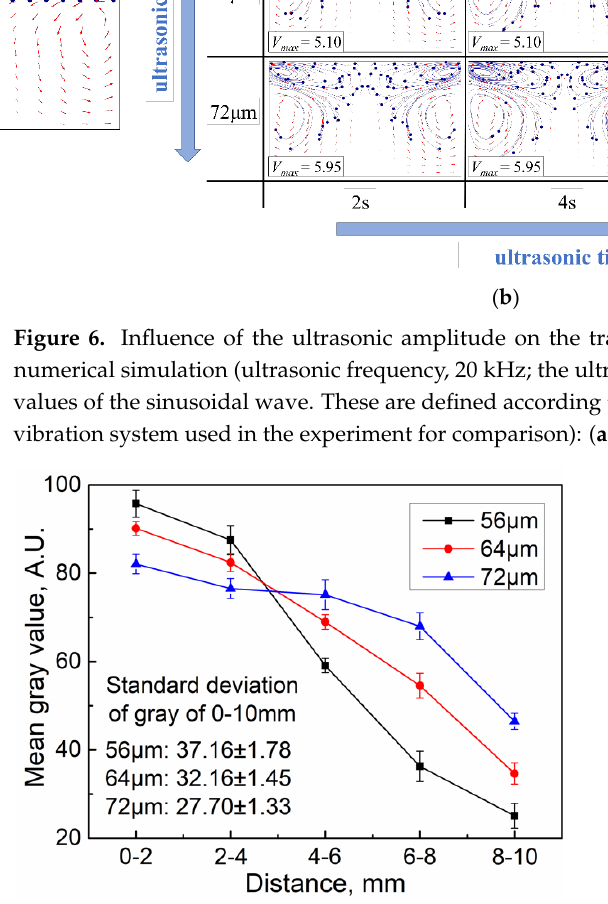
Figure 7. Influence of the ultrasonic amplitude on the mean gray value of the ultrasonic plasticized fluorescent specimens in the experimentation (ultrasonic frequency, 20 kHz; plasticizing pressure, 20 MPa; ultrasonic action time, 6 s; holding pressure, 20 MPa; holding time, 6